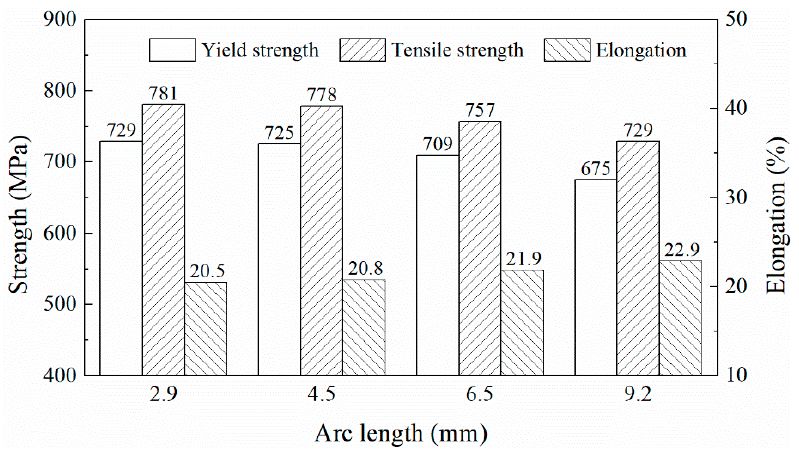
Figure 6. Tensile properties of weld metal under different arc lengths.